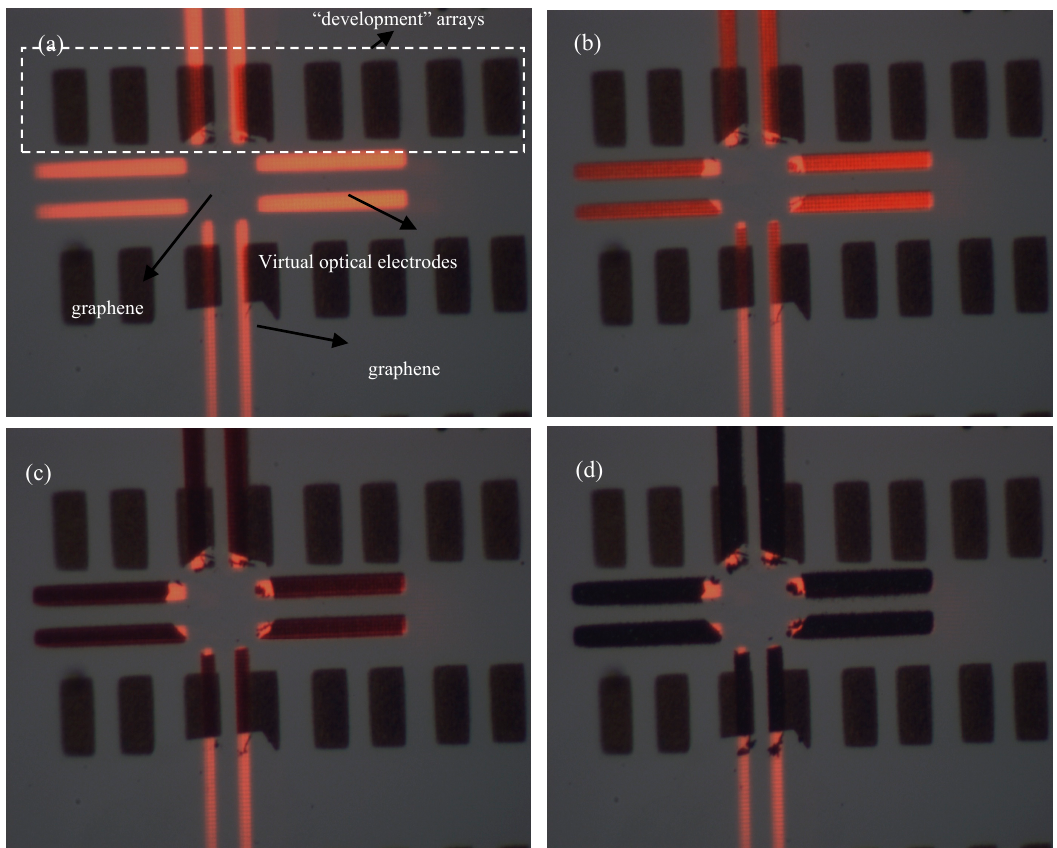
Figure 5. Optical images of the Ag electrodes deposition process using the OIED system. ( a ) Images of graphene appearing on the substrate though “development” arrays indicated by white dotted lines. The red rectangles are virtual optical electrodes designed by using a commercial personal computer software (Flash 11, Adobe); ( b – d ) Ag electrode deposition process. The shape of graphene becomes visible and the thickness of the electrodes increases during the process.